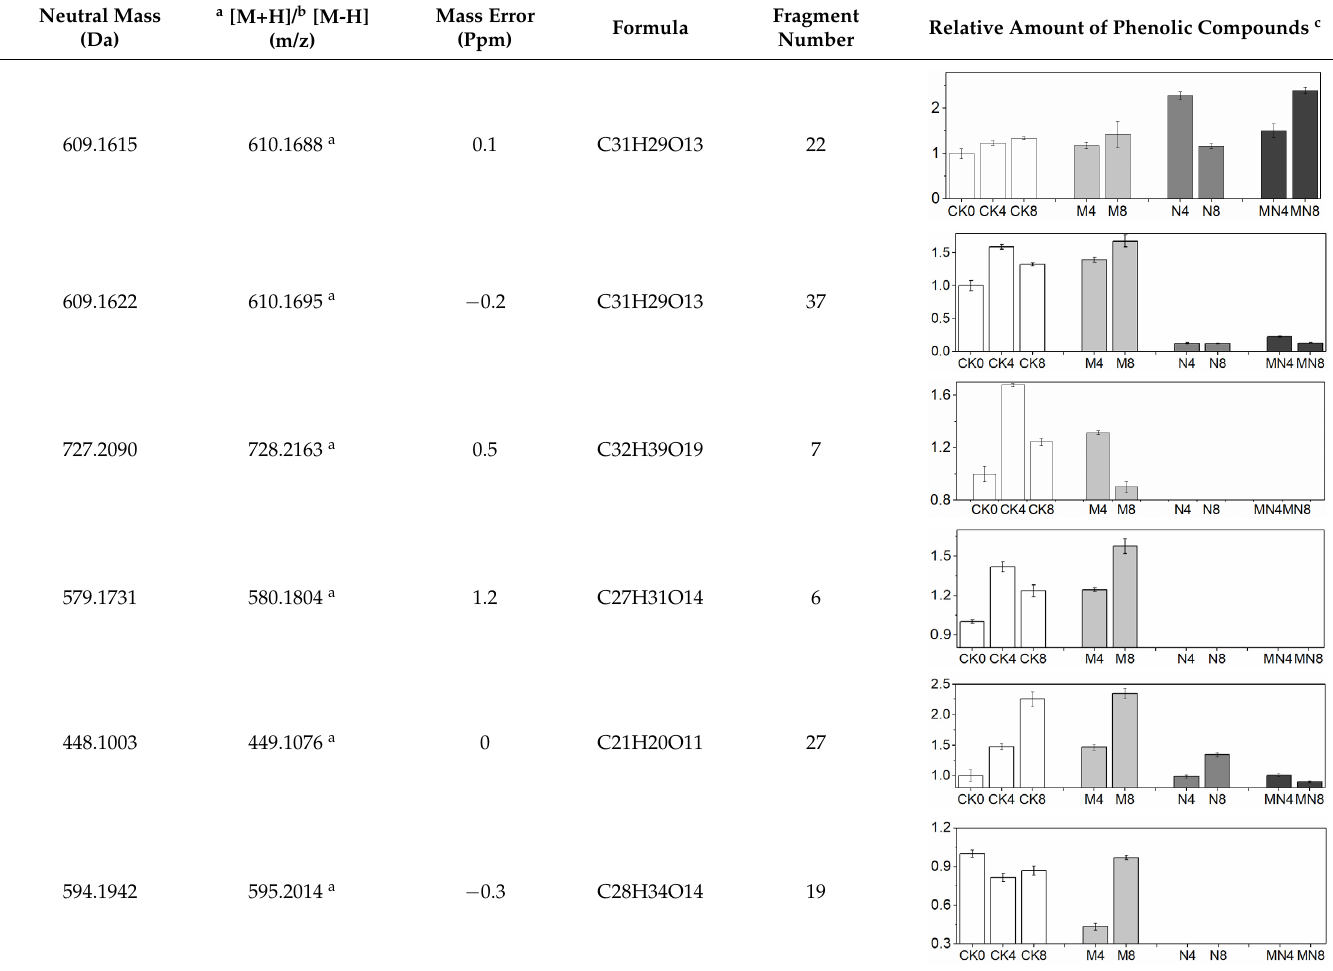
Table 2. Phenolic compounds analyzed by LC/MS.